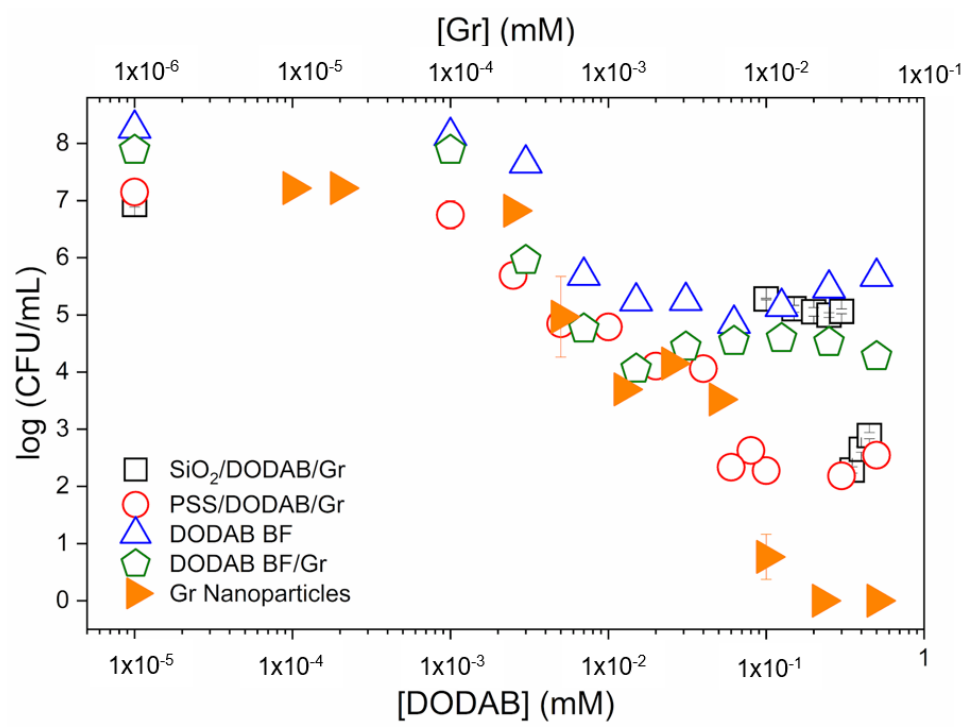
Figure 7. Cell viability of Staphylococcus aureus (10 7 –10 8 CFU/mL) after interacting for 1 h with gramicidin (Gr) nanoparticles or other Gr formulations in dioctadecyldimethylammonium bromide (DODAB) bilayers. Cell viability in the presence of Gr in DODAB supported bilayers on silica (SiO 2 /DODAB/Gr) [21], Gr in DODAB supported bilayers on polystyrene sulfate (PSS) nanoparticles (PSS/DODAB/Gr) [40], and DODAB bilayer fragments (DODAB BF [41] or DODAB BF/Gr [19]), all of them incorporating Gr. In the DODAB BF dispersions, Gr dimers in the channel conformation have been previously described [19,40]. The SiO 2 /DODAB/Gr stock dispersion was prepared at 2 mg/mL silica, 0.5 mM DODAB, and 0.05 mM gramicidin, yielding Dz = 280 ± 5 nm, P = 0.20 ± 0.02, and ζ = 45 ± 4.